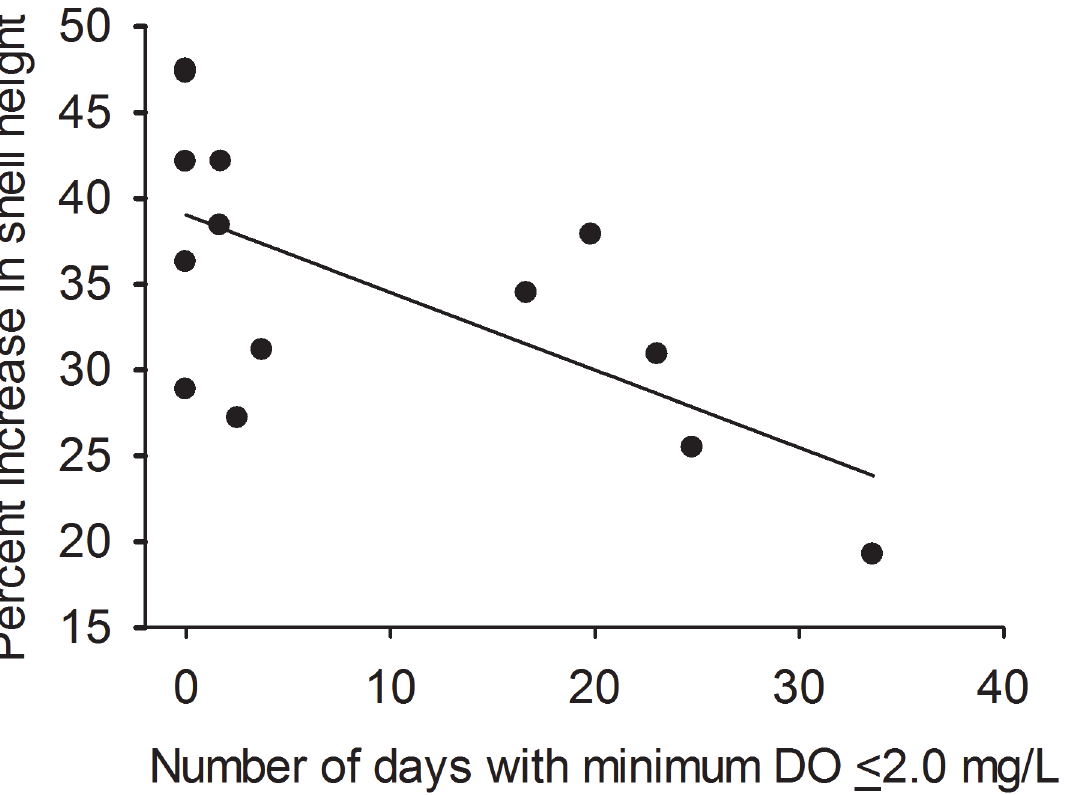
Fig 5. Percent increase in the shell height ( GROW ) of initially-uninfected (1yo) oysters versus the percentage of days with minimum DO concentration (cid:1) 2.0 mg l -1 ( HYP ) across 14 experiment deployment locations in Chesapeake Bay during 2008 and 2009. Regression line: GROW = 39.03 – 0.45 * HYP , r 2 = 0.41, P = 0.01, n =